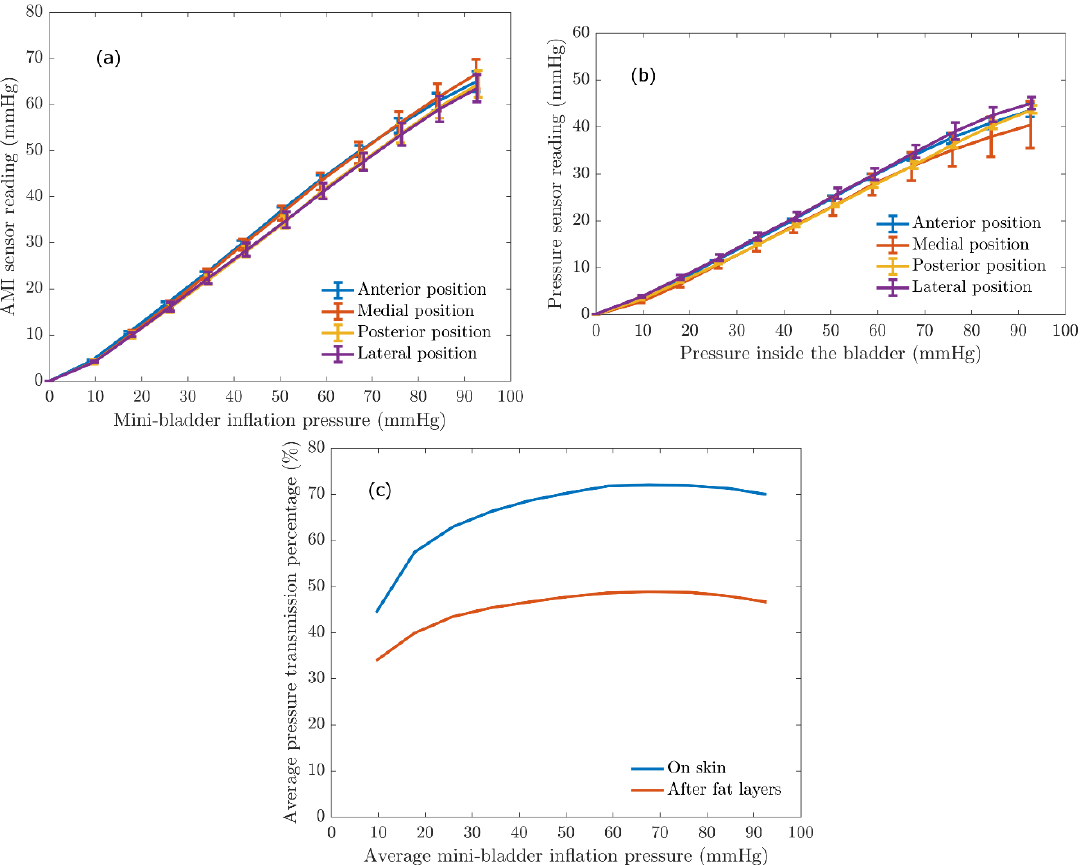
Figure 8. The relationship between the AMI sensor reading and the mini-bladder inflation pressure. ( a ) interface pressure on the artificial skin layer (Young’s modulus 0.22 MPa) ( b ) the pressure recorded by AMI air-pack sensor embedded in the fat layer (Young’s modulus 0.03 MPa) ( c ) Average pressure transmission percentage against the average mini-bladder inflation pressure, for outer skin layer and the inside fat layer of the leg surrogate.